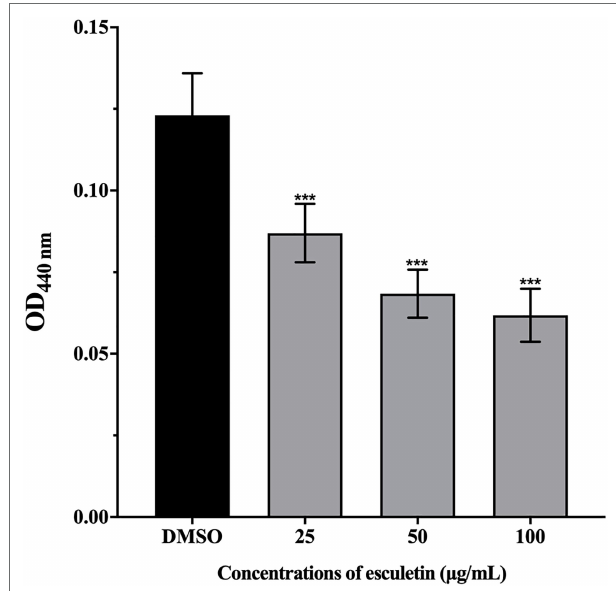
FIGURE 3 | Effect of esculetin at sub-MICs (25, 50, and 100 μ g/ml) on protease activity of A. hydrophila SHAe 115. Data are presented as the absorbance of mean ± SD of three independent experiments. *** p < 0.001 compared to the DMSO control group by one-way ANOVA.